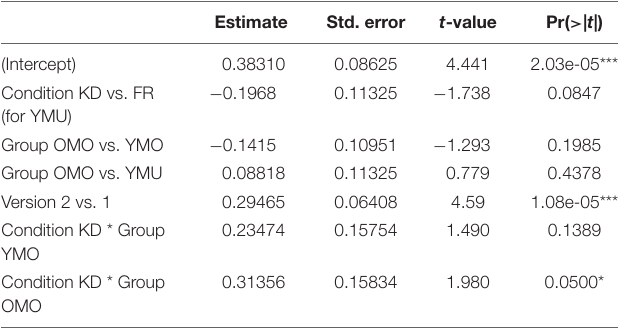
TABLE 7 | Summary statistics of the linear model with D -score as dependent variable and the influencing factors listener group , test order and experiment condition